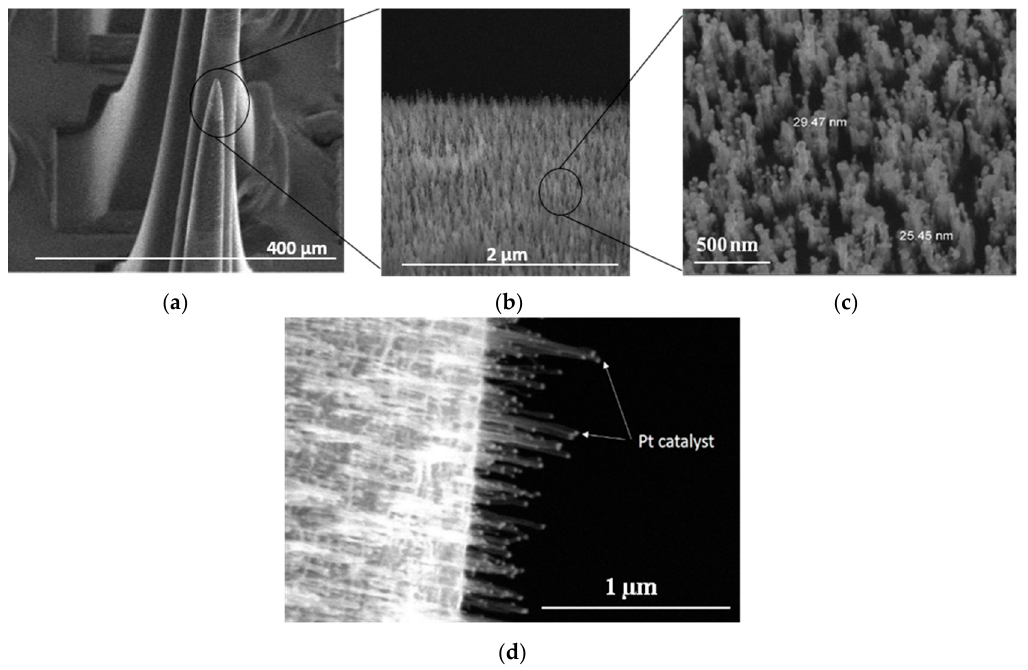
Figure 9 . SEM images of microelectrodes after tip-coating with CNTs: ( a – c ) at different magnifications. The geometry of CNTs increased the accessible surface area; and ( d ) Pt particles at the end of CNTs.